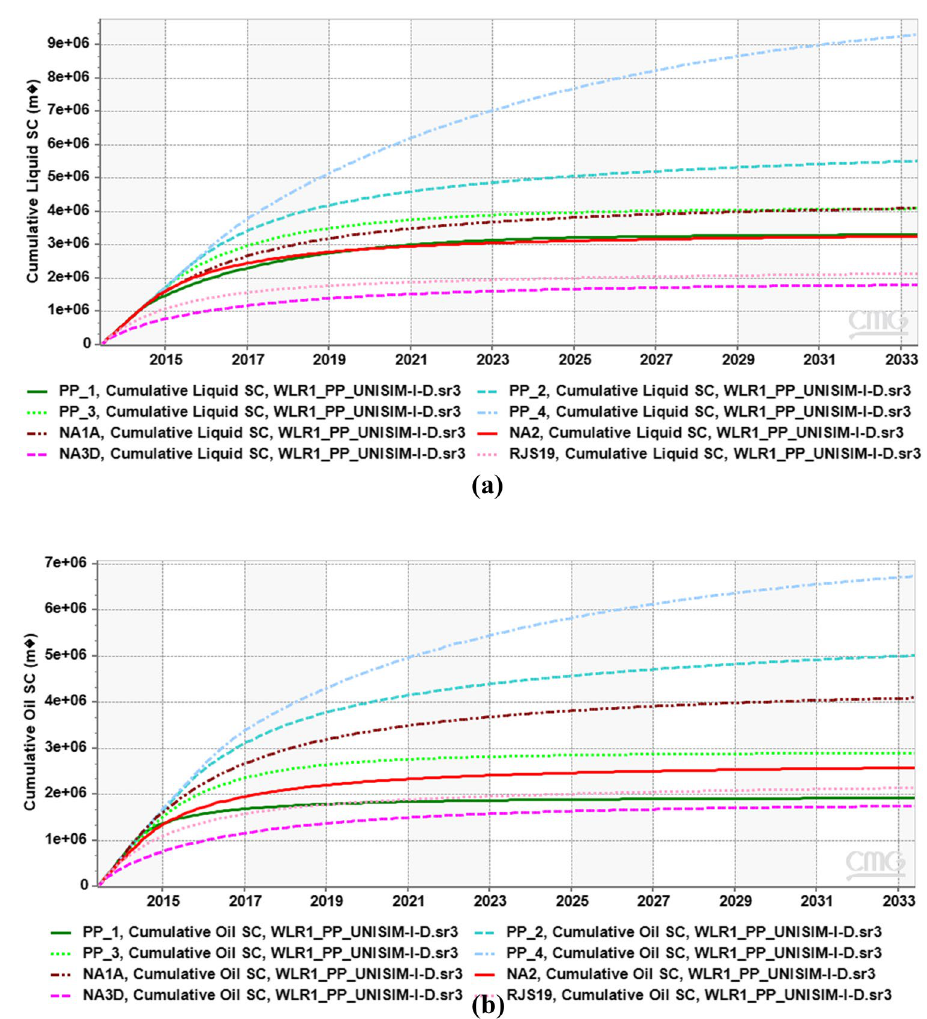
Fig. 8 COP-SC ( a ) and CLP-SC ( b ) for UNISIM and PP